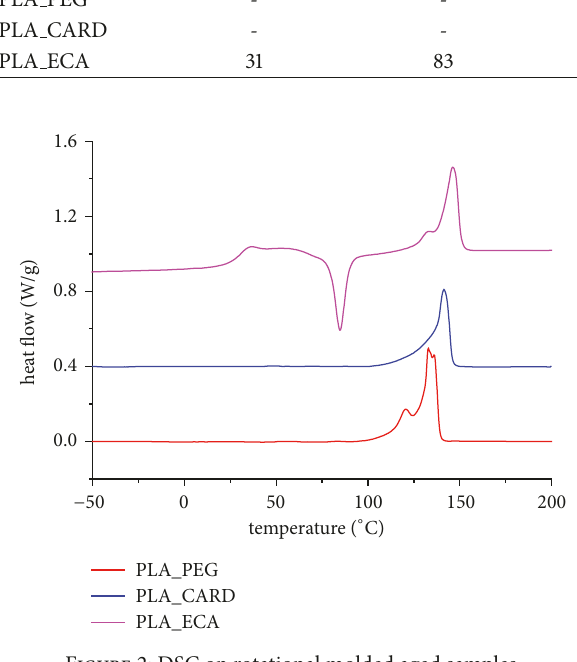
Figure 2: DSC on rotational molded aged samples.